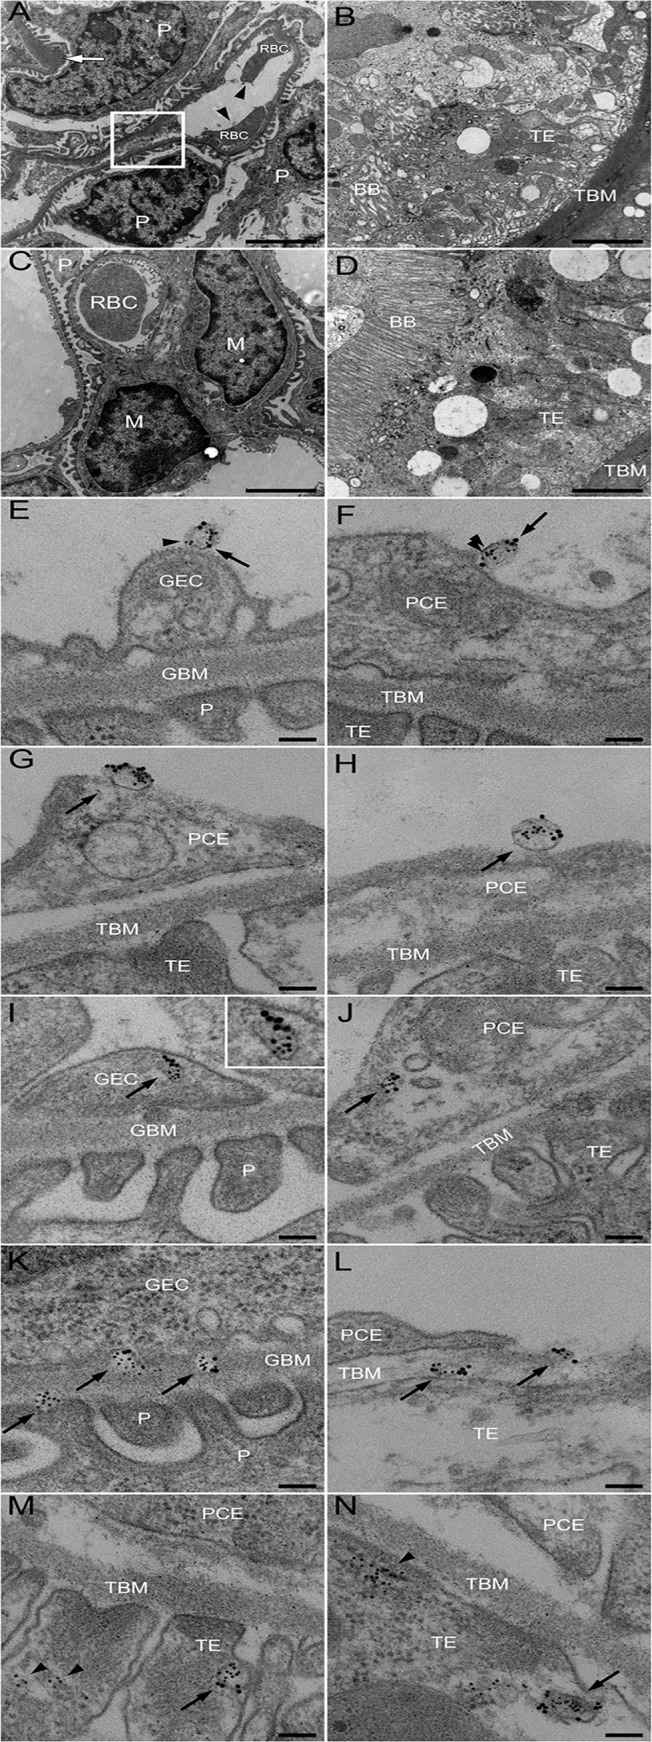
Ultramorphology of the renal cortex in mice infected with E. coli O157:H7.Representative overviews of glomerular (A, box depicts an area of endothelial damage with detachment from the basement membrane, arrow indicates thickening of the glomerular basement membrane and arrowheads point to fragmented RBCs in a glomerular capillary) and tubular (B) damage in infected mice. These are compared to a glomerulus (C, showing thin basement membranes and normal round RBC in a glomerular capillary) and tubulus (D) from uninfected mice, all taken on day 6 post-inoculation. Samples were co-incubated with rabbit anti-Stx2 (5 nm, arrowhead) and rat anti-mouse CD41 (10 nm, detects platelet-derived microvesicles, arrow) or rat anti-mouse CD45 (10 nm, detects leukocyte-derived microvesicles, arrow) showing binding of Stx2-containing microvesicles to glomerular (E, showing platelet microvesicle, F, showing leukocyte microvesicle) and peritubular capillary endothelial cells (G, platelet microvesicle, H, leukocyte microvesicle). Stx2-containing microvesicles were detected within glomerular (I, platelet microvesicle, see inset for enlargement) and peritubular (J, leukocyte microvesicle) capillary endothelial cells, glomerular (K) and tubular (L) basement membranes (both showing platelet microvesicles), within podocytes (K) and tubular epithelial cells (M, leukocyte microvesicle, N, platelet microvesicle). E-N taken on day 4 post-inoculation. Scale bar 100 nm. For detailed enlargement of microvesicles in panels I-N see S2 Fig. (in supporting information). P: podocyte, RBC: red blood cell, TE: tubular epithelial cell, BB: brush border, TBM: tubular basement membrane, M: mesangial cell, GEC: glomerular endothelial cell, GBM: glomerular basement membrane, PCE: peritubular capillary endothelium.